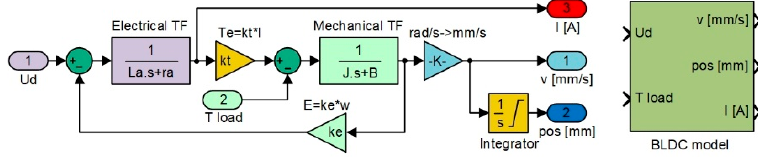
/ Simulink model of Brushless DC (BLDC) motor. Figure 6. MATLAB/Simulink model of Brushless DC (BLDC) motor. Figure 6. MATLAB